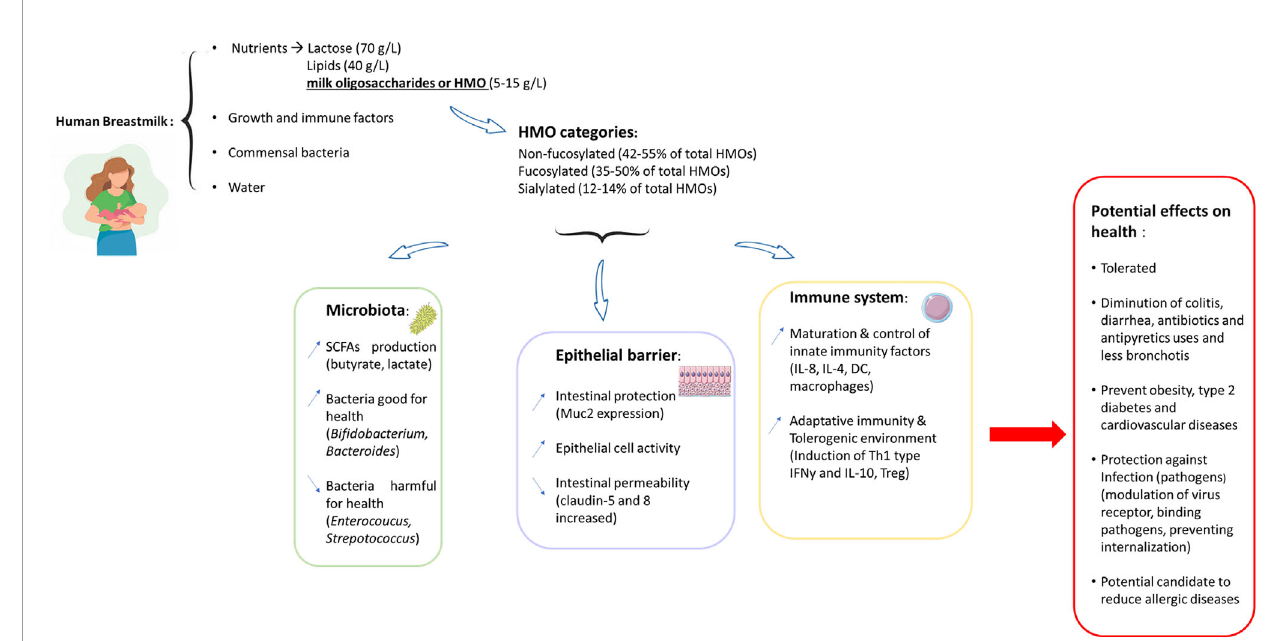
FIGURE 1 | Graphical abstract: bene fi cial effects of HMOs on human